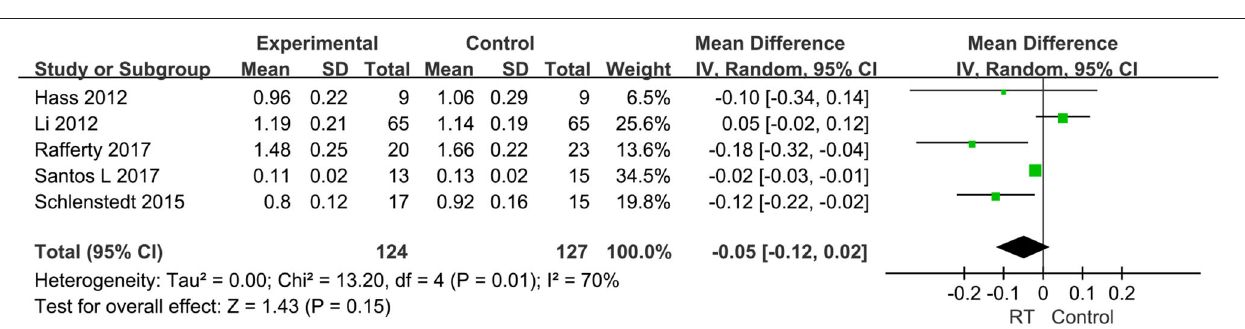
FIGURE 5 | Forest plots of the effects of lower limb RT on gait performance—stride length in PD. CI, confidence interval.